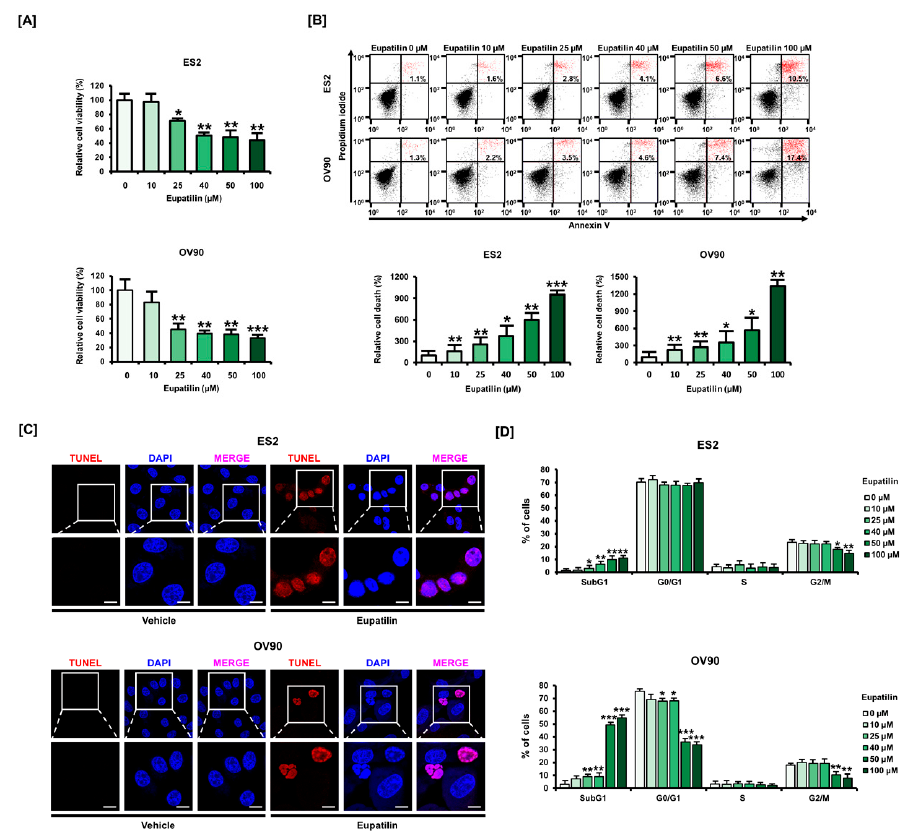
Figure 1. Anticancer e ff ects of eupatilin on ovarian cancer. ( A ) The e ff ects of eupatilin on the cell viability of ES2 and OV90 ovarian cancer cell lines. ( B ) Evaluation of cell death mechanisms in eupatilin-treated ES2 and OV90 cells using annexin-V-fluorescein isothiocyanate (FITC) / propidium iodide (PI) dual-staining analysis. ( C ) Apoptotic cells were stained with terminal deoxynucleotidyl transferase dUTP nick end labeling (TUNEL), a red fluorescent dye. DAPI, a blue fluorescent dye, was used as a positive control in both ES2 and OV90 cells treated with eupatilin. The scale bar indicates 20 µ m. ( D ) ES2 and OV90 cells were treated with increasing concentrations of eupatilin and stained with PI to estimate cell cycle distribution using a flow cytometer. The experiments were performed in triplicate. Data represent the mean ± standard deviation, and asterisks indicate that the e ff ect of treatment was statistically significant (* p < 0.05, ** p < 0.01, and *** p <